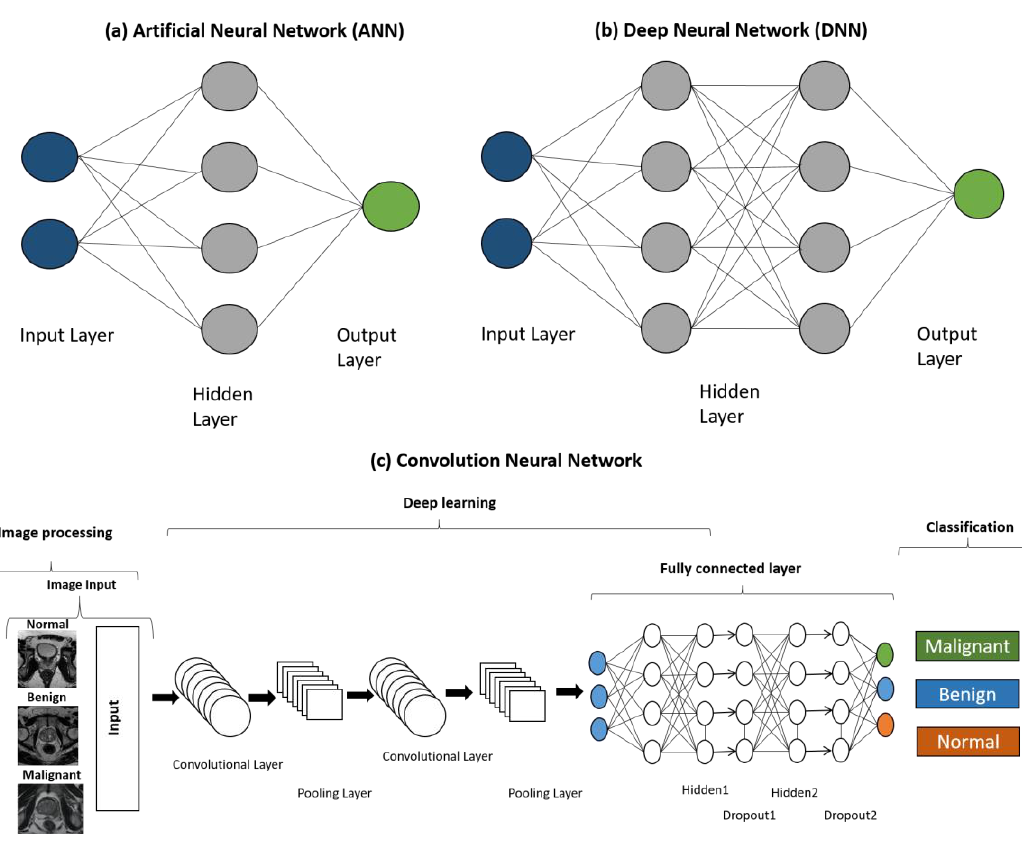
Figure 2. The architecture of neural network machine learning models for data processing and analysis, i.e., ( a ) ANN, ( b ) DNN, and ( c ) CNN methods.